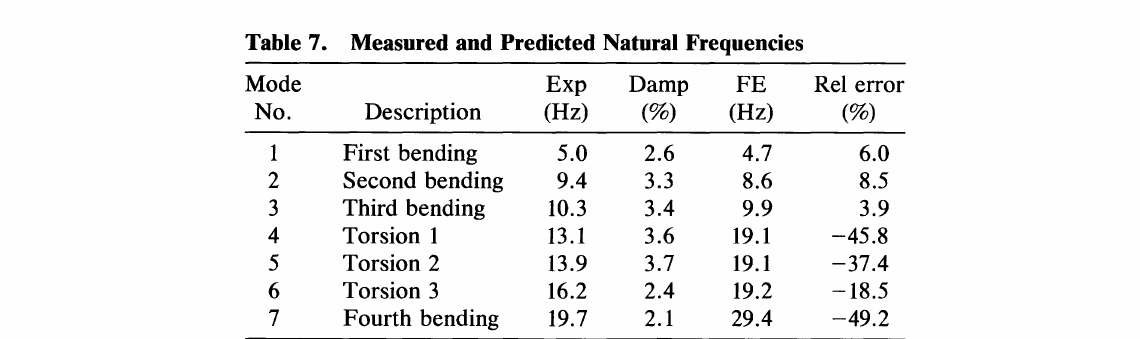
Table 7. Measured and Predicted Natural